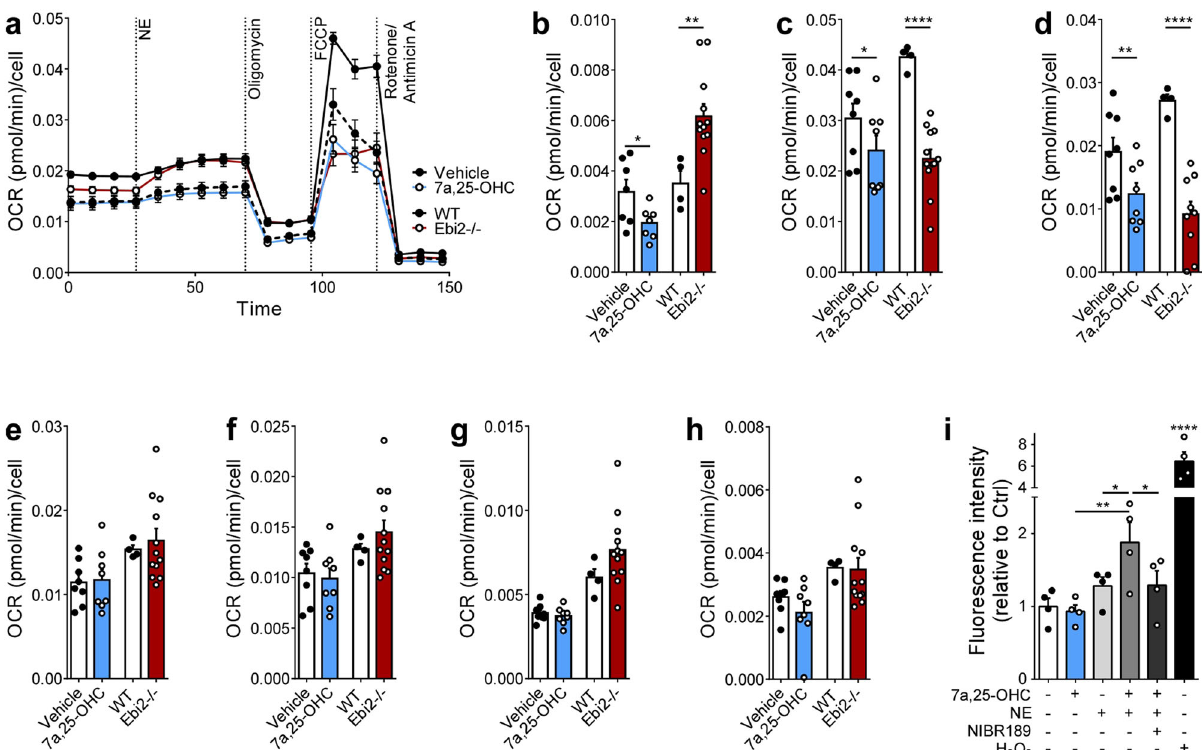
Fig. 3 The effect of EBI2 signaling on brown adipocytes respirometry and ROS generation. a In vitro respirometry of brown adipocytes pre-treated with 7 α ,25-OHC (1 µ M), and EBI2 − / − brown adipocytes ( n = 6 independent samples). b – h NE-induced O 2 consumption ( b ), maximal respiration ( c ), spare respiratory capacity ( d ), basal respiration ( e ), ATP production ( f ), proton leak ( g ) and non-mitochondrial respiration ( h ) of brown adipocytes pre-treated with 7 α ,25-OHC (1 µ M), and EBI2 − / − brown adipocytes ( n = 6 independent experiments). i ROS production in brown adipocytes after 1 h treatment